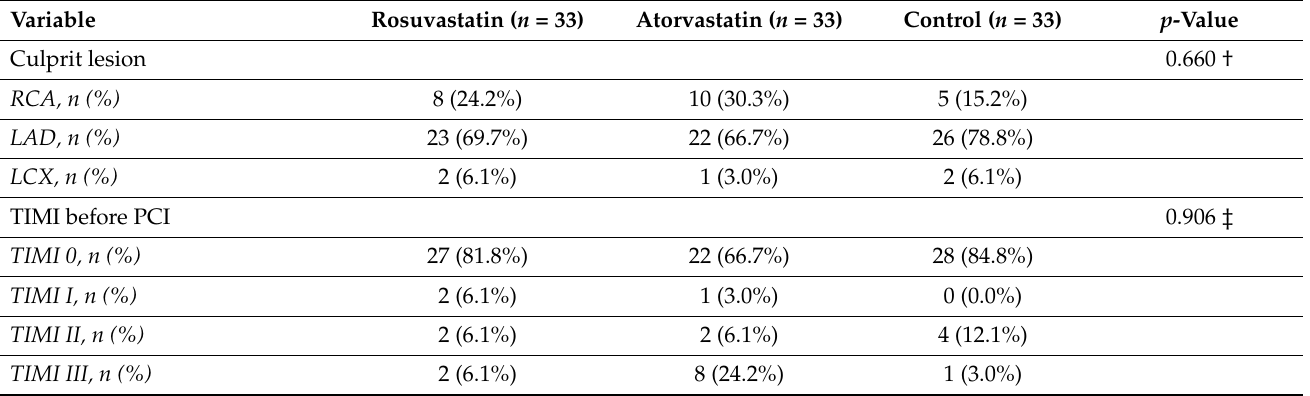
Table 2. Coronary angiographic findings in the three study